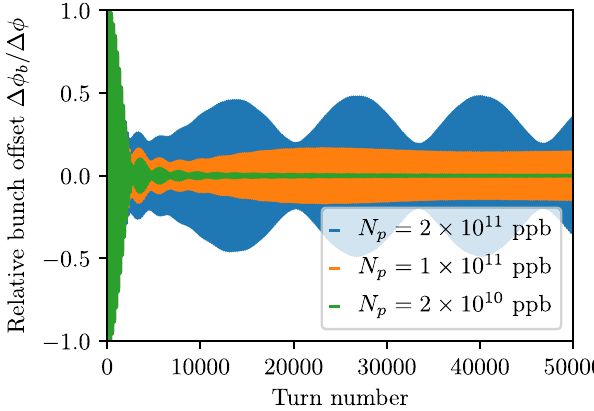
FIG. 9. Offset evolution of bunch with different intensities described by Eq. (62) after a kick of Δ ϕ ¼ 1 deg for a broadband resonant impedance with Im Z=k ¼ 0 . 07 Ω , f Q ¼ 1 ; V 0 ¼ 6 MV, zero-intensity τ 4 σ ¼ 0 . 82 ns, and μ ¼ 2 . In this case, the calculated LLD threshold N